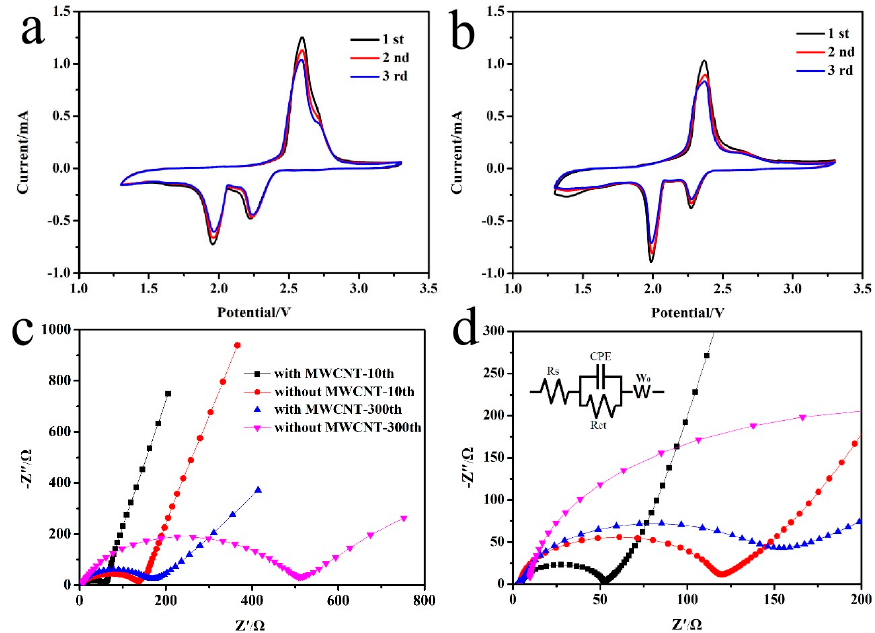
Figure 7. ( a ) Cyclic voltammogram of batteries without MWCNTs, and ( b ) with MWCNTs, ( c , d ) EIS data shown in the format of Nyquist plots of ‐ Z ″ vs. Z ′ for Li ‐ S batteries and the equivalent circuit diagram of impedance spectrum.